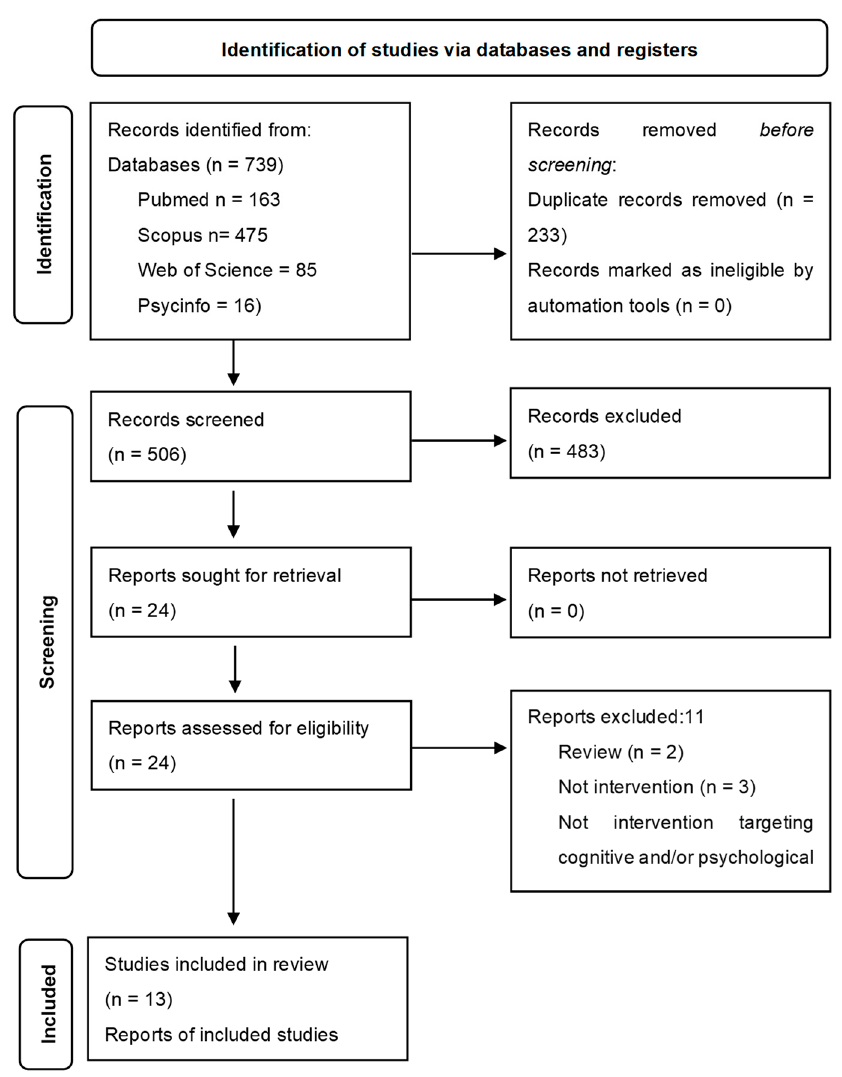
Figure 1. Preferred Reporting Items for Systematic Reviews and Meta ‐ Analyses flowchart of the systematic